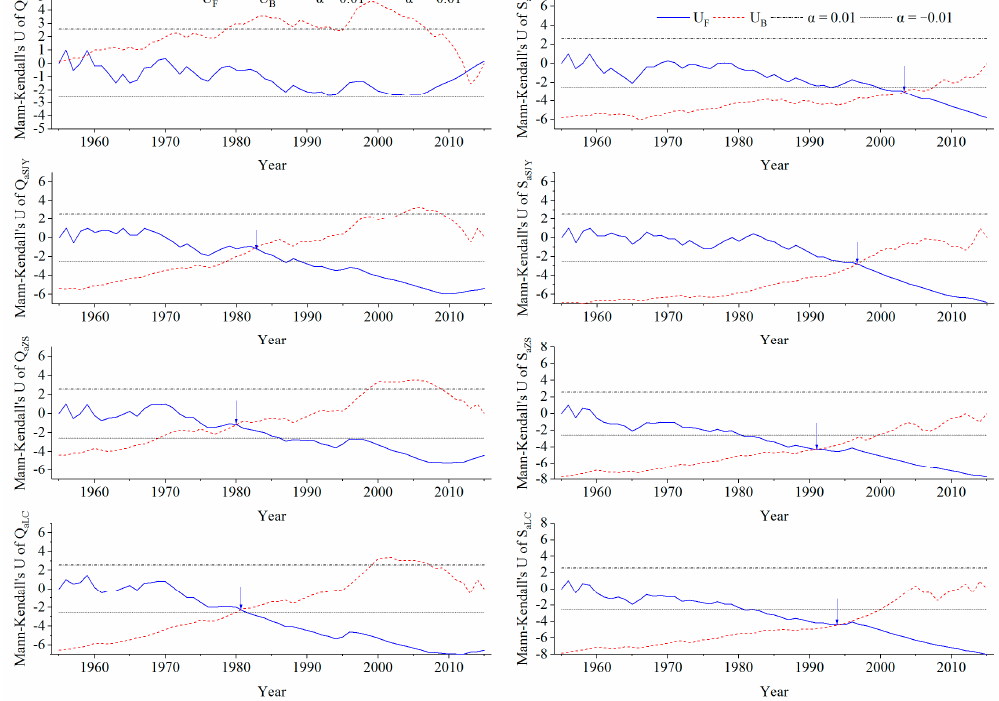
Figure 3. Mann–Kendall tests of the Q a and S a values for four hydrological stations from 1955 to 2015. The horizontal dashed lines represent the critical values corresponding to the 99% significance level. Solid blue arrow denotes inflection point years during the study period using Mann–Kendall tests. 3.2. Temporal Variation of Q a − P ma and S a − P ma Based on Double Mass Curves Cumulative Q a and S a values were plotted against cumulative P ma values for the four stations (Figure 4). Except for the double mass curve of Q aJL − P maJL , which manifested as a straight line without segmentation, the other double mass curves for S aJL − P maJL , Q aSJY − P maSJY , and S aSJY − P maSJY unanimously trended rightwards with abrupt inflection points occurring in 1982 and 1996. The double mass curves of Q a − P ma and S a − P ma for ZS and LC, respectively, varied nearly synchronously, with the same abrupt inflection points occurring in 1980 and 1996, respectively, in the cumulative Q a − P ma curves and for the cumulative S a − P ma curves in 1959, 1980, and 1996.